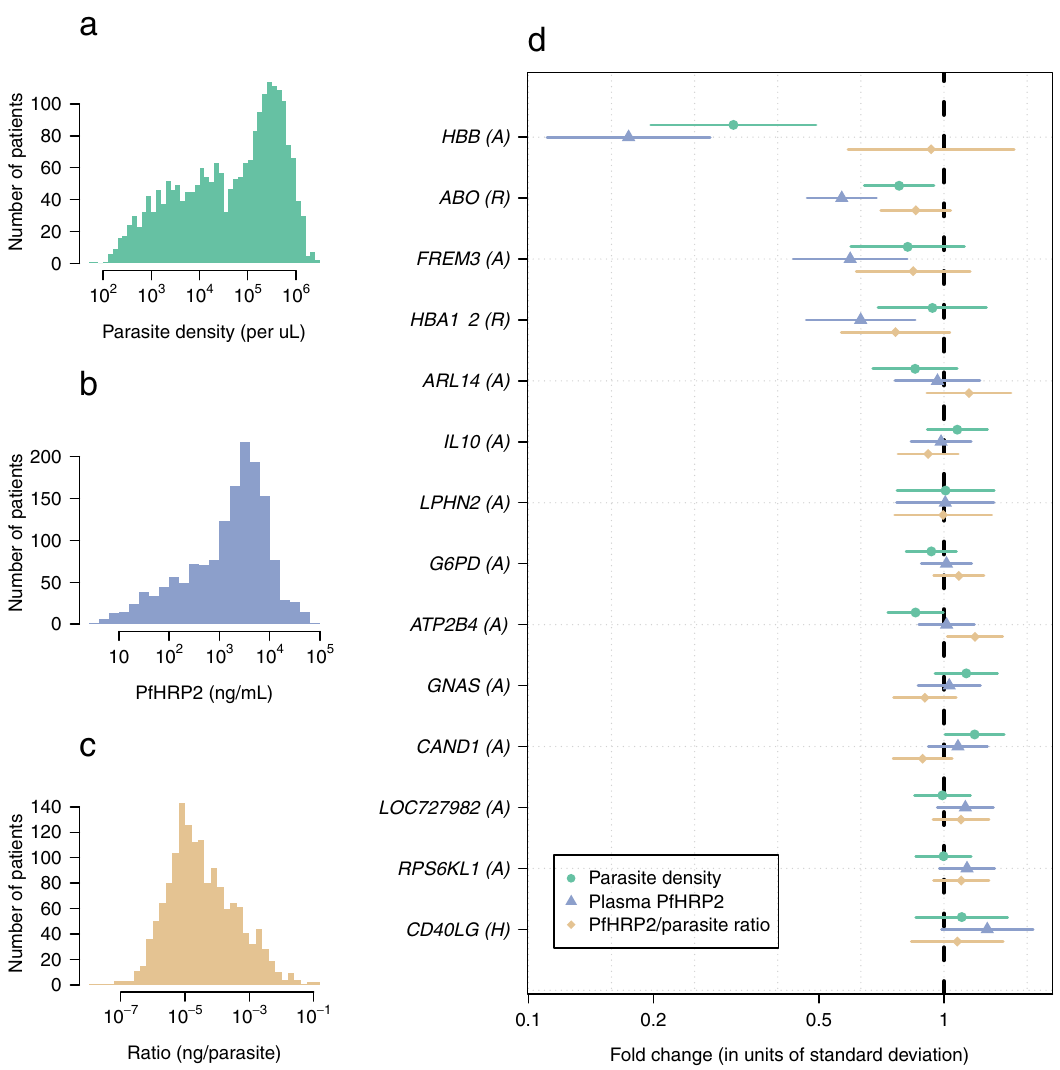
Fig. 1 Case-only genetic association study using 14 targeted variants and three quantitative traits. a – c Distributions of the three quantitative traits (observed data: parasite density in green; Pf HRP2 in purple; ratio Pf HRP2/parasites in orange). d Effect estimates (95% con fi dence intervals) expressed as fold changes on the standardized trait distribution (rescaled to have mean 0 and standard deviation